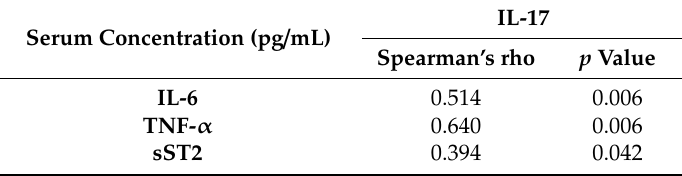
Table 3. Positive correlation of IL-17 with TNF- α , IL-6 and sST2 in sera of